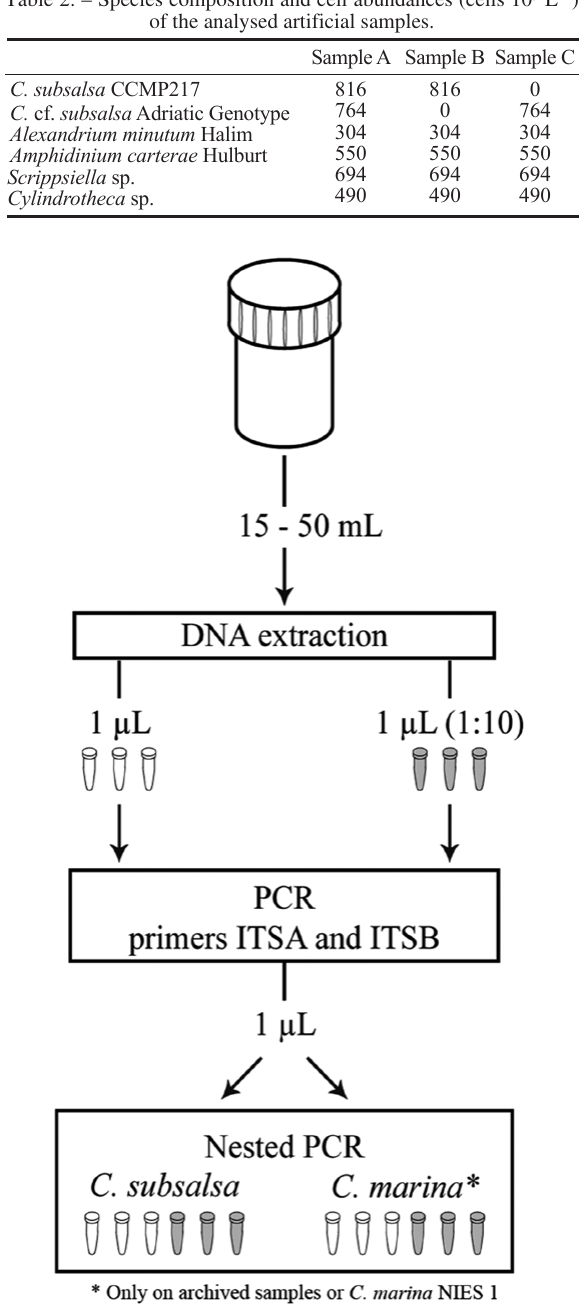
Fig. 2. – Scheme of the protocol used; in the first passage, 50 mL of archived samples, 15 mL of artificial samples or 15 mL of cultures were